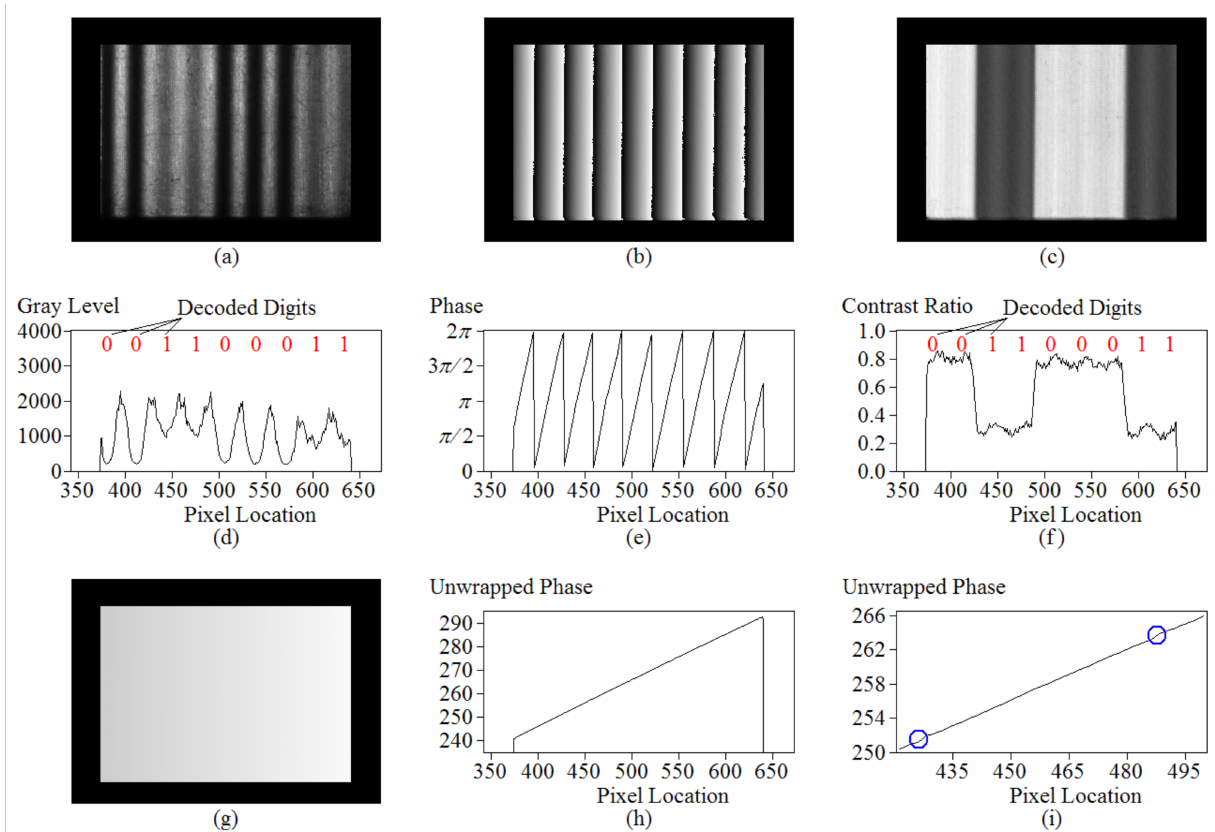
Figure 9. ( a ) A photo that was recorded using the CCD camera for the first pattern projection on the standard block. ( b ) The phase map that was extracted using the 5-step phase-shifting algorithm. ( c ) The contrast map (extracted using the 5-step phase-shifting algorithm). ( d ) The gray-level distribution along one image row. ( e ) The phase distribution along the sampled image row. ( f ) The corresponding 1D contrast distribution. ( g ) The phase map that was unwrapped using codewords. ( h ) The unwrapped phase distribution along the sampled image row. ( i ) A close-up view of the distribution shown in ( h